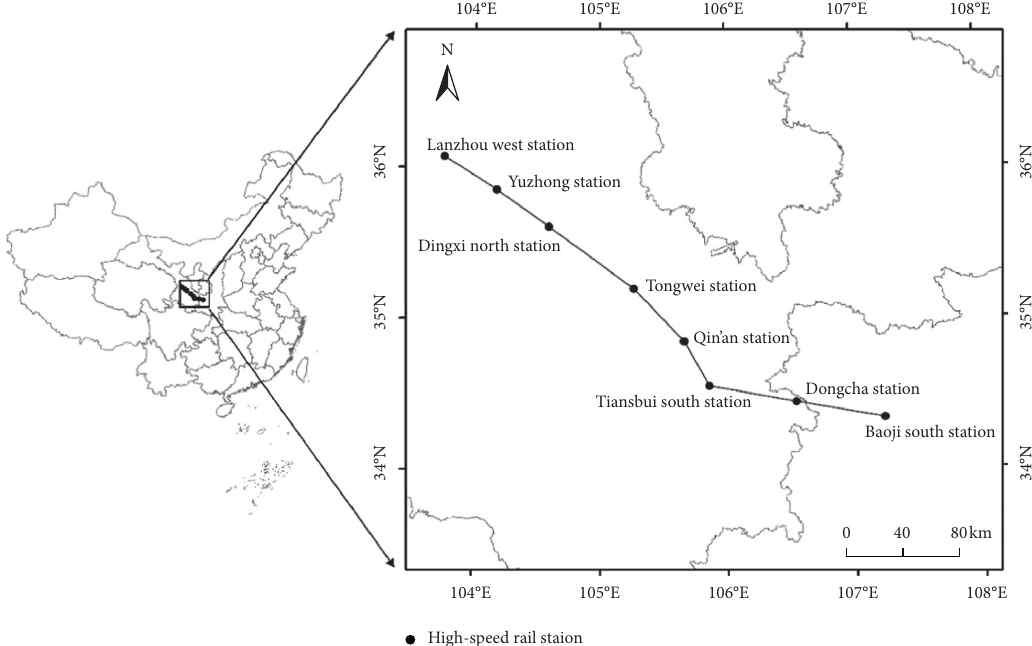
Figure 1: Location of the test site along the Lanzhou-Baoji line in China.